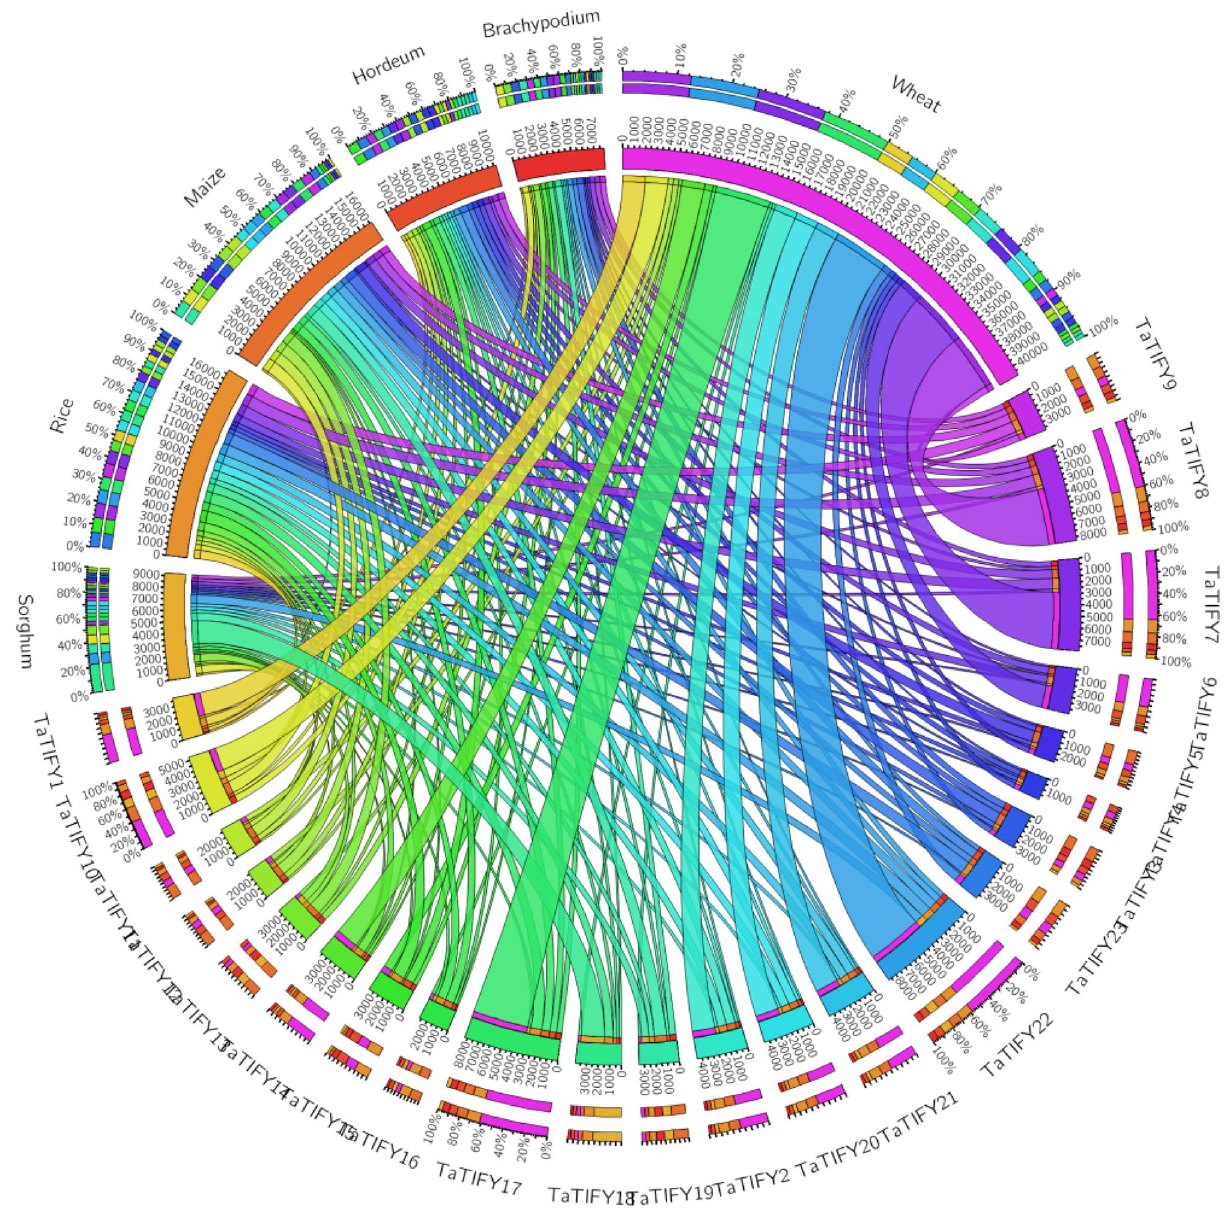
Figure 6. Comparative synteny and expansion analysis of TaTIFY TF genes with sorghum, rice, maize, Hordeum and Brachypodium based on orthologous and paralogous pair positions that demonstrates highly conserved